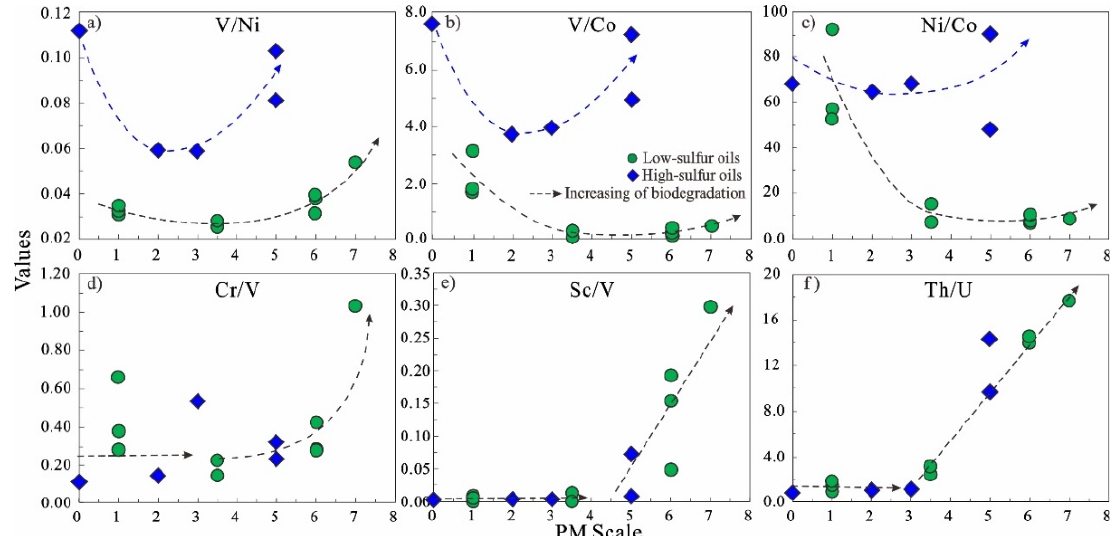
Figure 11. Cross plots showing changes in the ratios of some trace elements based on increasing biodegradation levels (PM scale). ( a ) Cross plot of PM Scale versus V/Ni; ( b ) Cross plot of PM Scale versus V/Co; ( c ) Cross plot of PM Scale versus Ni/Co; ( d ) Cross plot of PM Scale versus Cr/V; ( e ) Cross plot of PM Scale versus Sc/V; ( f ) Cross plot of PM Scale versus Th/U.